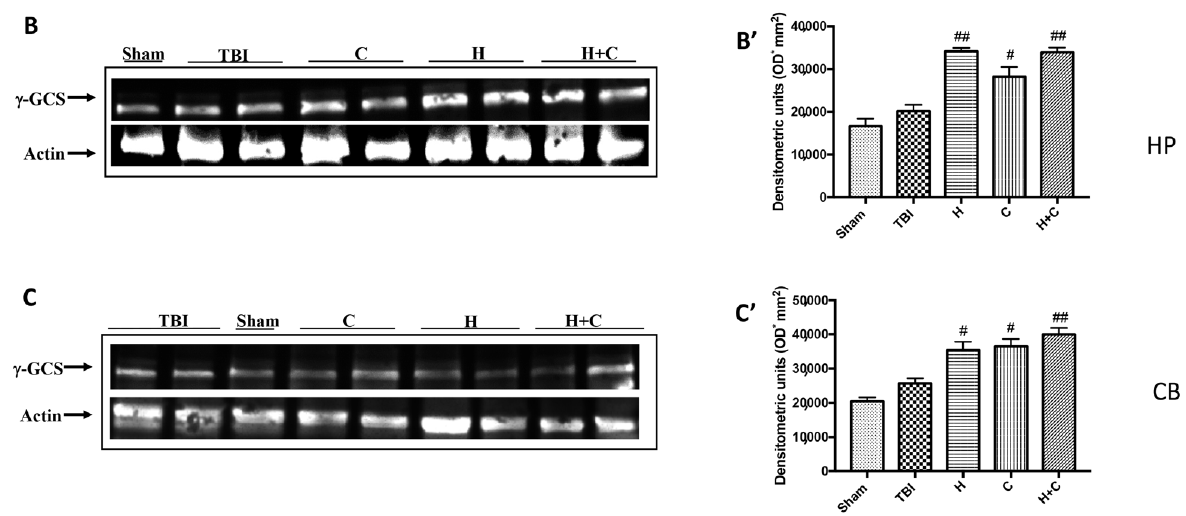
Figure 10. Effect of H. erinaceus or C. versicolor , or H. erinaceus + C. versicolor treatment on γ -GCS protein after chronic TBI. Western blot analysis showed that the expression of γ-GCS increased insignificantly in the TBI group in CX ( A ), HP ( B ) and CB ( C ) regions. H, C, and H + C treatment further significantly increased the expression of γ-GCS in CX, HP and CB regions ( A – C ). The data are expressed as the mean SEM from n = 5 mice/group. Densitometry analysis: ( A’ ) # p < 0.05 vs. TBI; # p < 0.05 vs. TBI; ## p < 0.01 vs. TBI; ( B’ ) ## p < 0.01 vs. TBI; # p < 0.05 vs. TBI; ## p < 0.01 vs. TBI; ( C’ ) # p < 0.05 vs. TBI; # p < 0.05 vs. TBI; ## p < 0.01 vs. TBI. Finally, the expression of the Trx protein was significantly increased by treatments with H, C and H + C only in Cx and Hp. No significant increase was observed at the Cb level (Figure 11 A–C, see relative densitometry analysis A’, B’, C’).